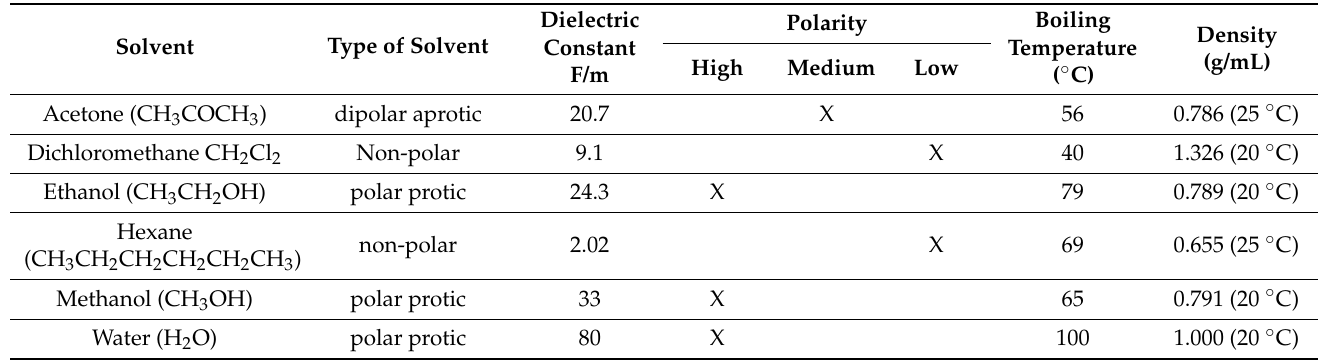
Table 2. Characteristics of the solvents